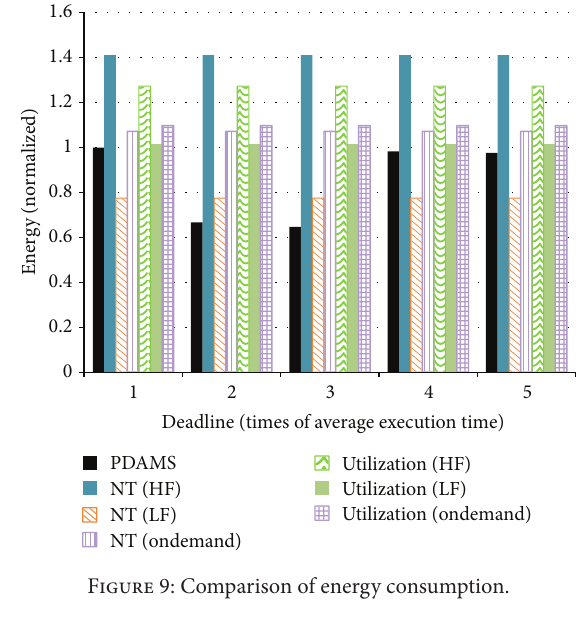
Figure 9: Comparison of energy